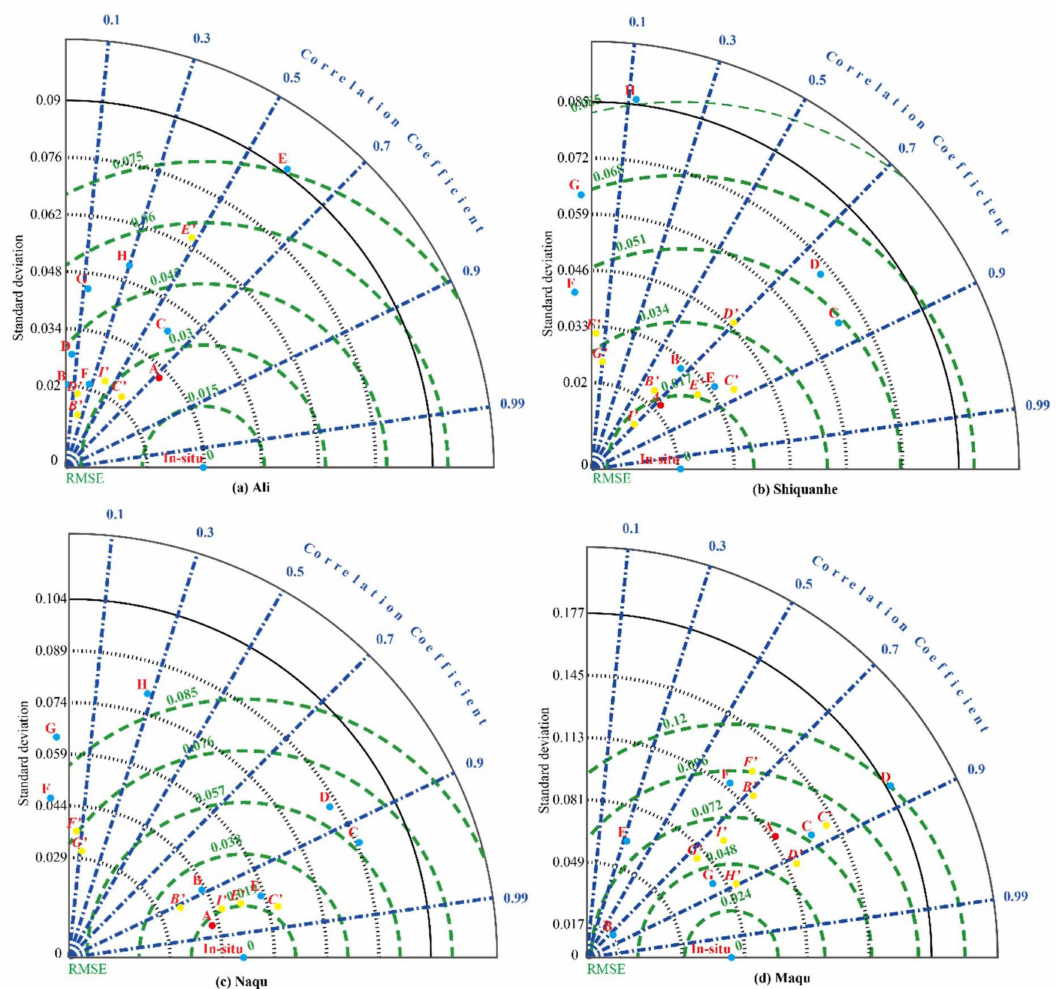
Figure 8. Taylor Diagrams of Inter-comparison between Blended Data and Others: ( a ) Ali; ( b ) Shiquanhe; ( c ) Naqu; ( d ) Maqu; A with red dot represents the blended SSM product; B, C, D, E, F with cyan dots represent the original SSM products SMOS, AMSR2, SMAP, ERA-Interim, merged PASSIVE, ESA-CCI merged ACTIVE; B , C , D , E , F with yellow dots represent the in-situ climatology scaled SSM data; H and I represent a simple averaged of original products and a simple average of scaled